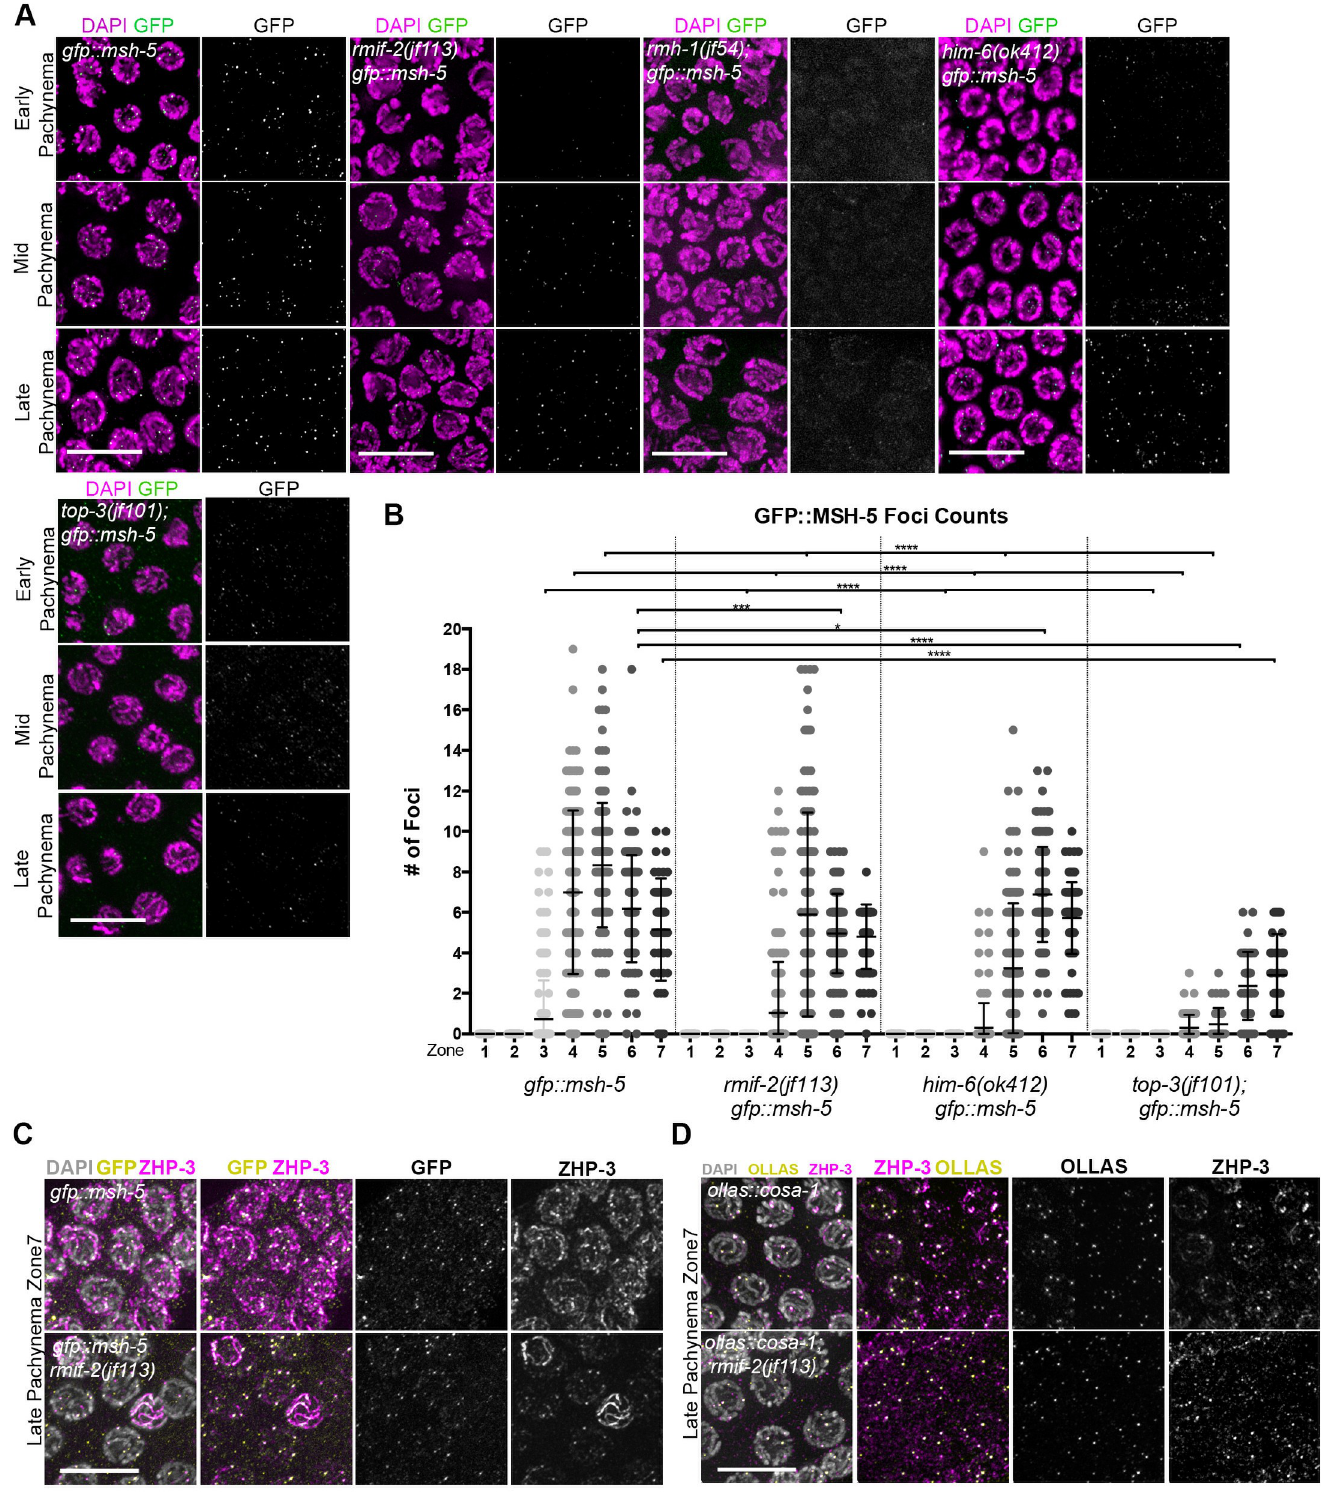
Fig 6. GFP::MSH-5 localization in BTR complex mutants. (A) Representative images of GFP::MSH-5 nuclear foci (in green) and DAPI (in magenta) in early, mid, and late pachynema in the gfp :: msh-5 and rmif-2(jf113) gfp :: msh-5 , rmh-1(jf54); gfp :: msh-5 , him-6(ok412) gfp :: msh-5 and top-3(jf101); gfp :: msh-5 mutants. Scale bars, 10 μ m. (B) Quantification of GFP::MSH-5 nuclear foci in gfp :: msh-5 , rmif-2(jf113) gfp :: msh-5 , him-6(ok412) gfp :: msh-5 and top-3(jf101); gfp :: msh-5 mutants.